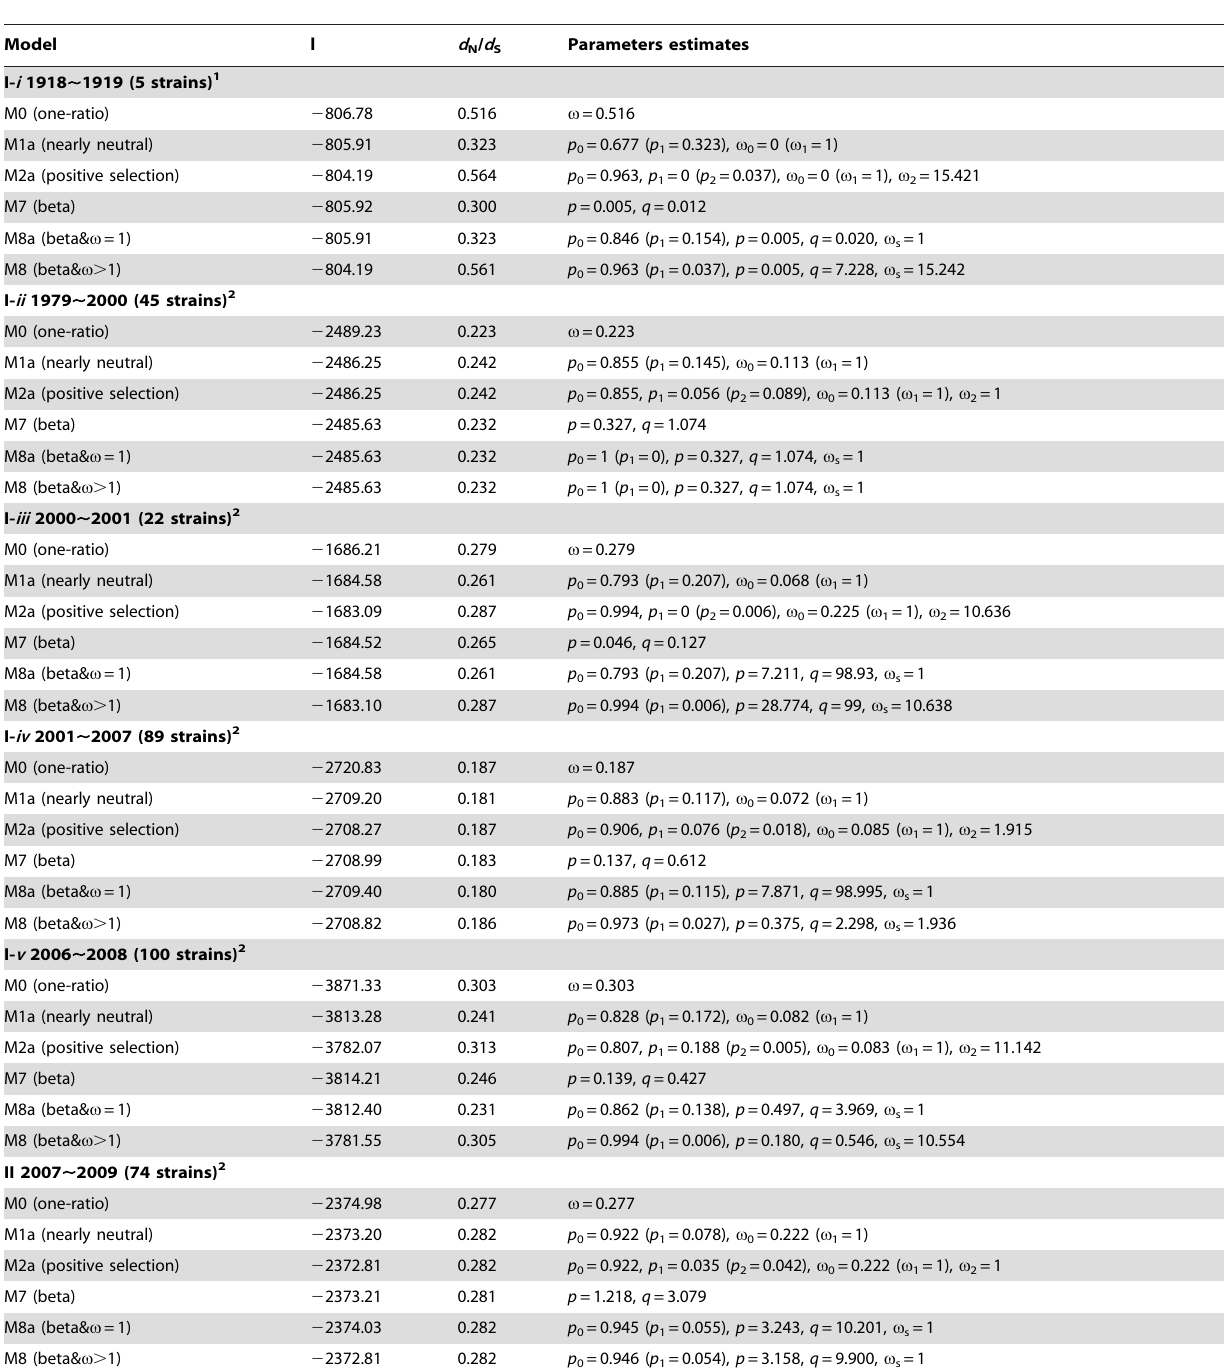
Table 1. The values of log-likelihood (l), d N / d S , and parameter estimates in CODEML analysis of human A(H1N1) Has.